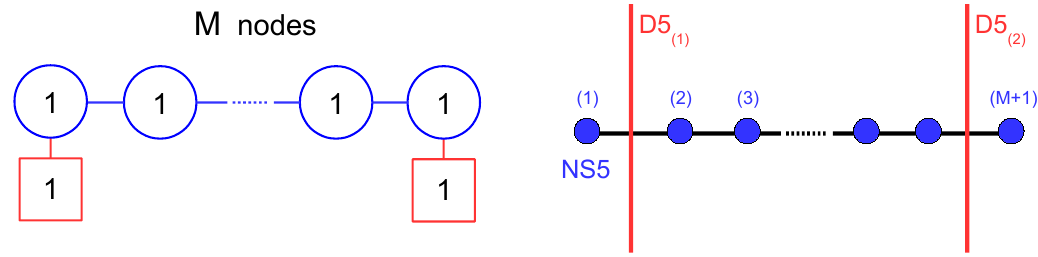
Figure 20 . Quiver and brane con(cid:12)guration of the abelian quiver T abel with M abelian nodes. There are M + 1 NS5 branes in the brane